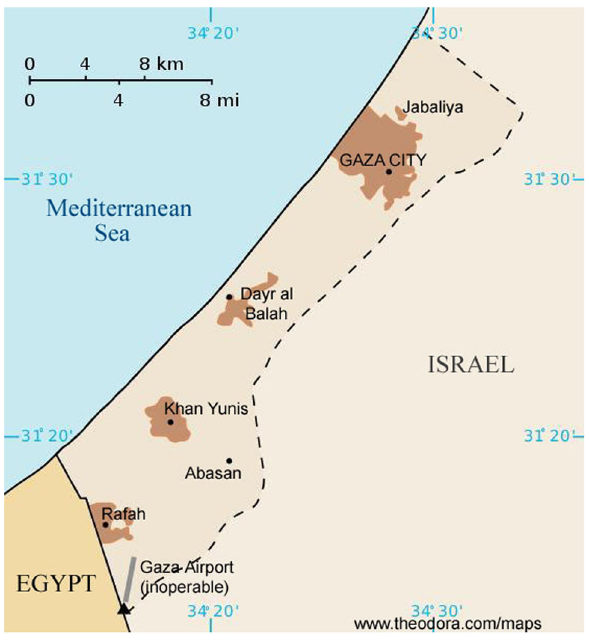
Fig. 1 Gaza Strip map. Source: https://www.theodora.com/maps